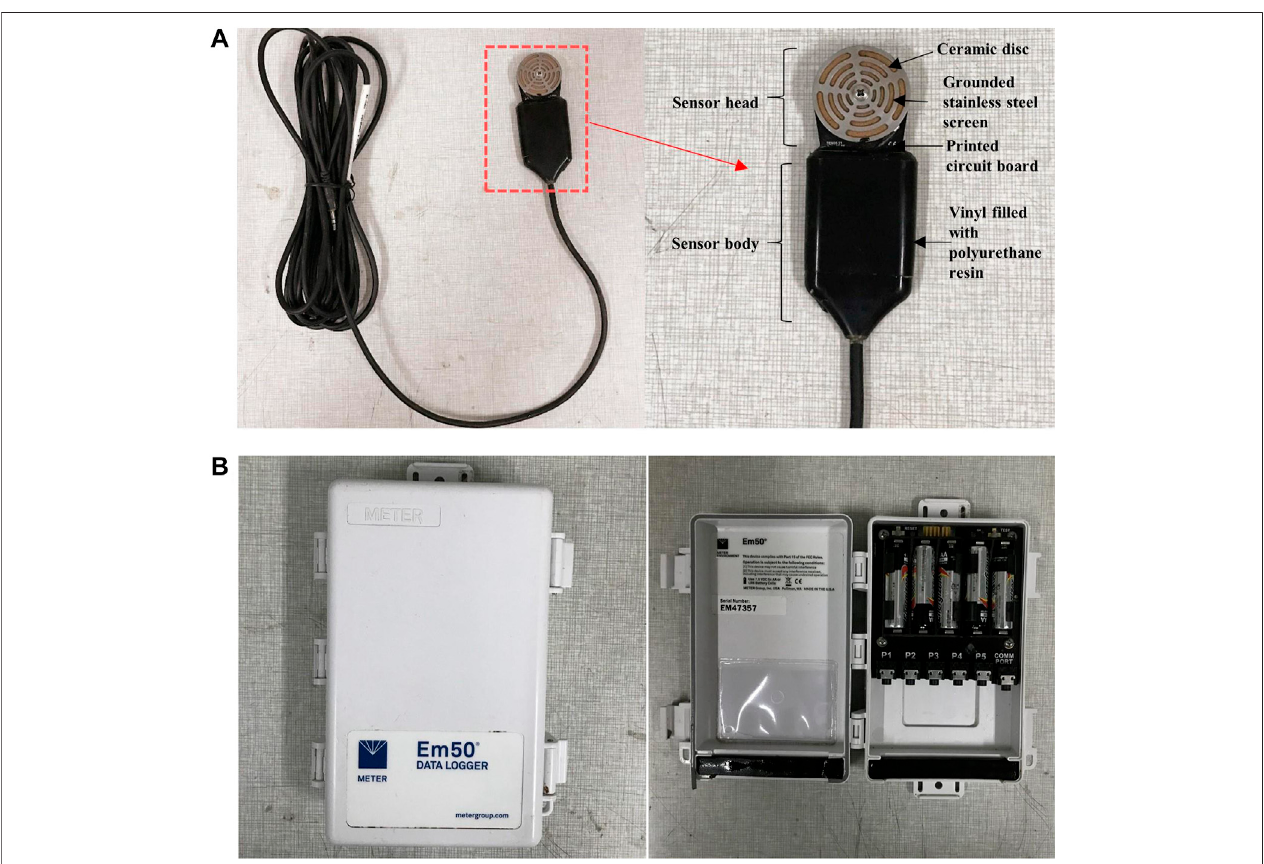
FIGURE 2 | TEROS 21 water potential meter. (A) TEROS 21 water potential sensor; (B) Em50 water potential collector.